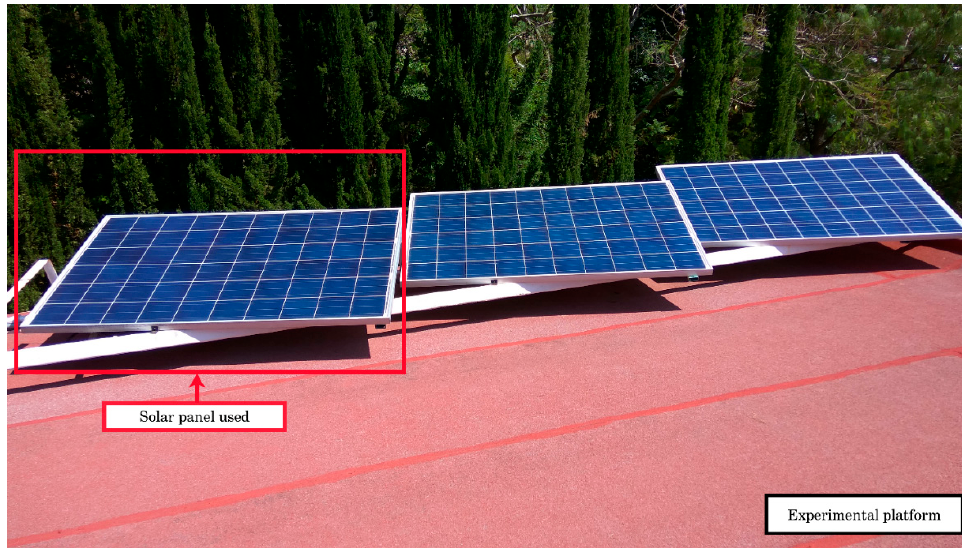
Figure 16. Eco Green Energy EGE-260P-60 solar panel used.